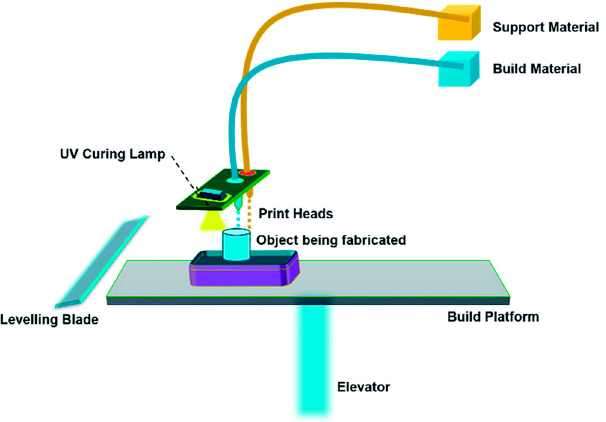
Figure 29. Material jetting process (adapted with permission from reference [72]).